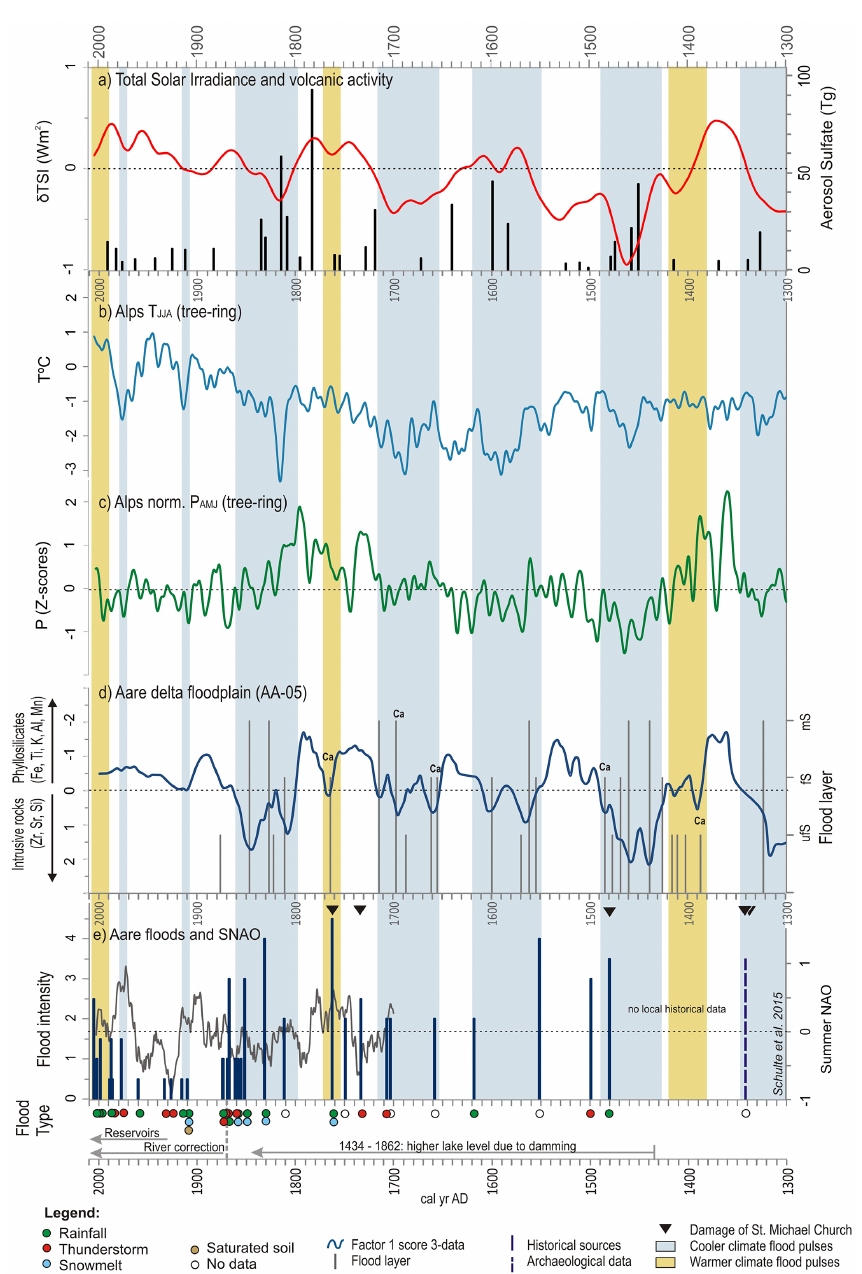
Figure 8. Comparison between historical flood reconstruction of the Hasli–Aare and solar and volcanic activity and climate proxies (1300– 2010calyrAD). (a) 40-year averaged variations of total solar irradiance (Steinhilber et al., 2009) and annual stratospheric volcanic sulfate aerosol injection, Northern Hemisphere (Gao et al., 2008). (b) JJA temperature anomalies (13-year Gaussian low-pass filter) in the European Alps reconstructed from larch density series (Büntgen et al., 2006). (c) AMJ precipitation anomalies (13-year Gaussian low-pass filter) in the European Alps reconstructed from larch density series (Büntgen et al., 2006). (d) Sedimentary palaeoflood proxy from the Aare Delta plain in the lower Hasli Valley (this paper). Factor 1 scores (3-data centred moving average equivalent to 13-year resolution) of chemical composition of core AA-05 samples and coarse-grained flood layers (ufS: silty fine sand; fS: fine sand; mS: middle sand). (e) Historical flood chronology of the Aare River (Hasli Valley) from documentary, archaeological and geomorphological evidences like in Fig. 7 (this paper). Triangles represent damage to the Sankt Michael church by flooding and severe aggradation caused by the Alpbach River.